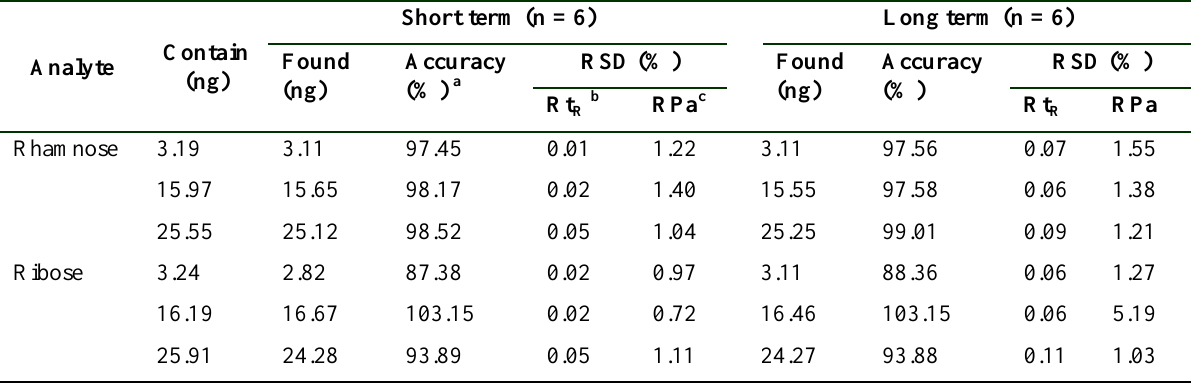
Table 2. Short and long term accuracy of the analytical